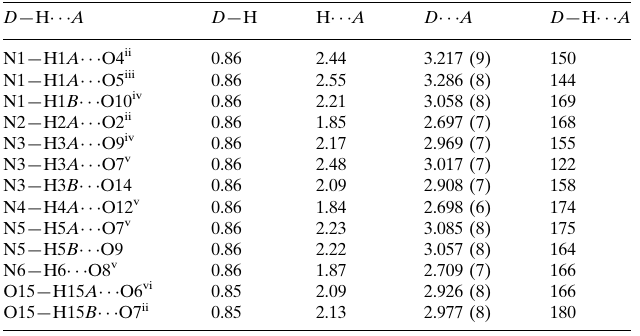
Hydrogen-bond geometry (A˚ , (cid:3)